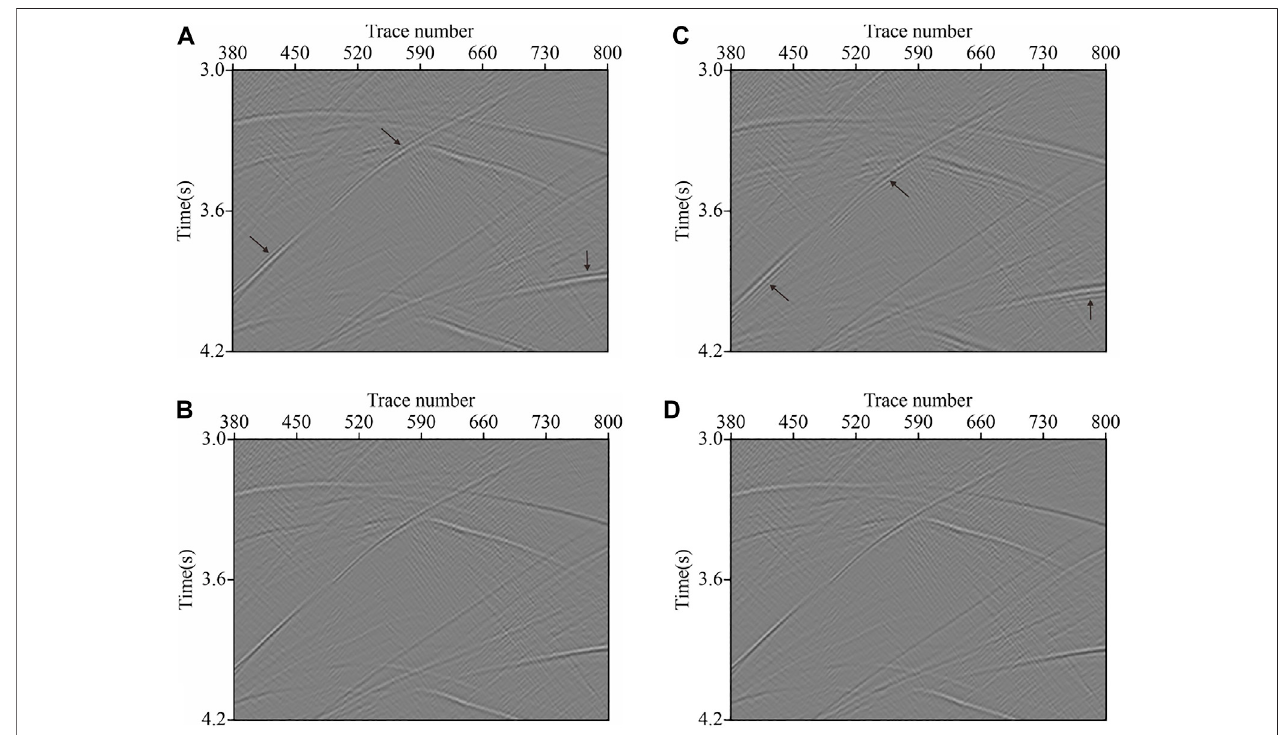
FIGURE 11| Local parts of the elastic record of the υ z component for the complexstructuralmodel simulated withtimestep Δ t (cid:2) 1 . 0ms: (A) C-SFD ( M =10); (B,C) M-SFD ( M =8; N =1) with the FD coef fi cients calculated based on the P-wave and S-wave time-space domain dispersion relation, respectively; (D) M-SFD ( M =8; N =1), solving the decomposed P-wave and S-wave